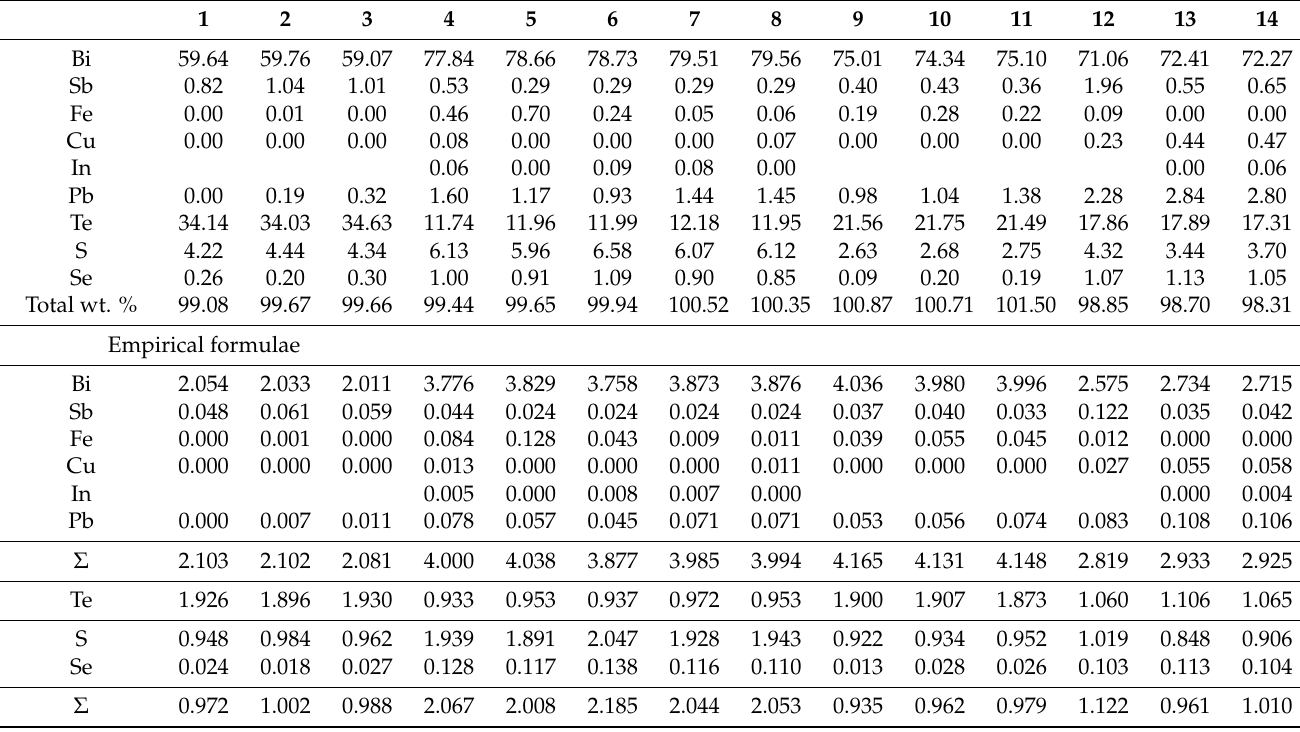
Table 7. Chemical composition of tetradymite (an. 1–3), jos é ite-A (an. 4–8), jos é ite-B (an. 9–11) and “protojos é ite”, Bi 3 (TeS) 2 , (an. 12–14) from ˇCuˇcma (Majersk á valley).